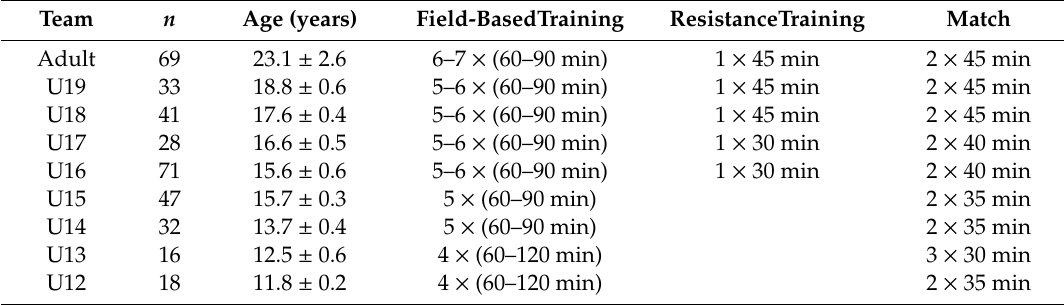
Table 1. Chronological age and overview of weekly training / match frequency for selected